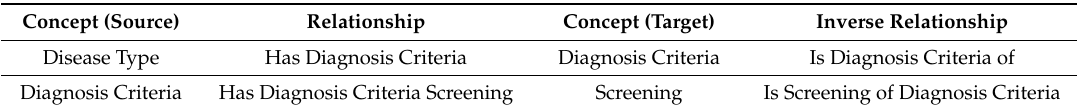
Table 2. Identified relationships.